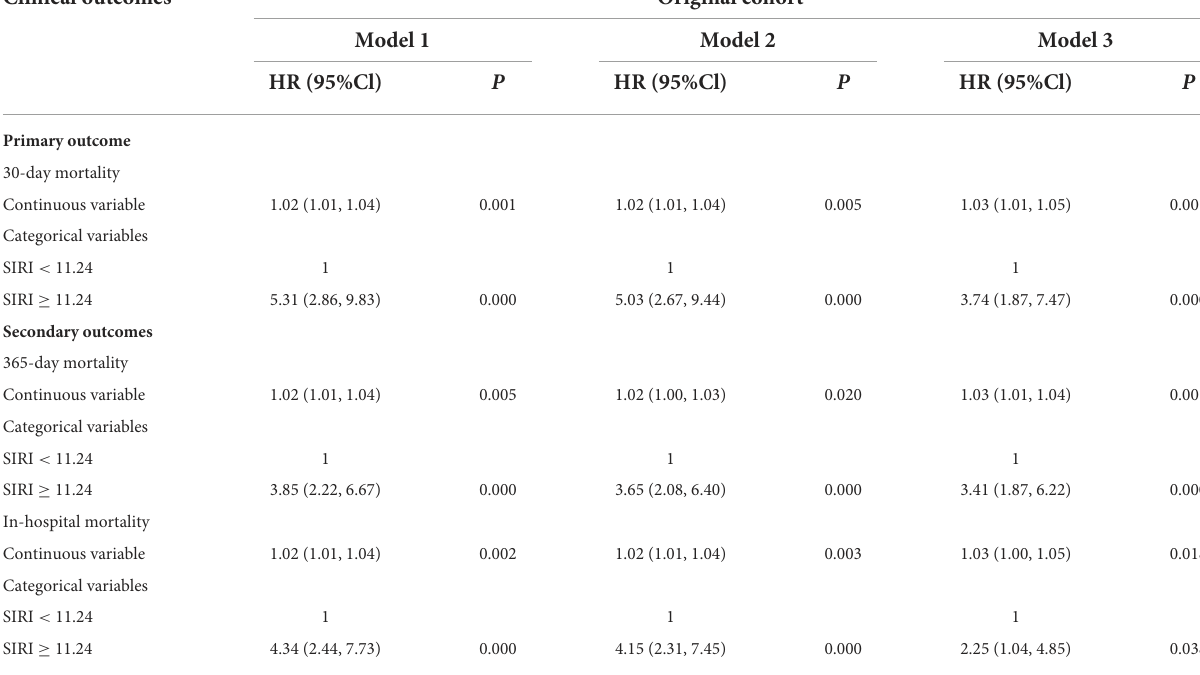
TABLE 2 Association between SIRI and clinical outcomes of critically ill patients with TBI before